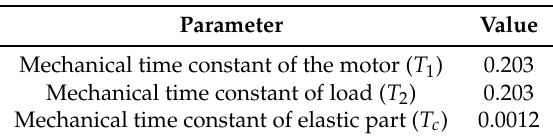
Table 1. The two-mass system